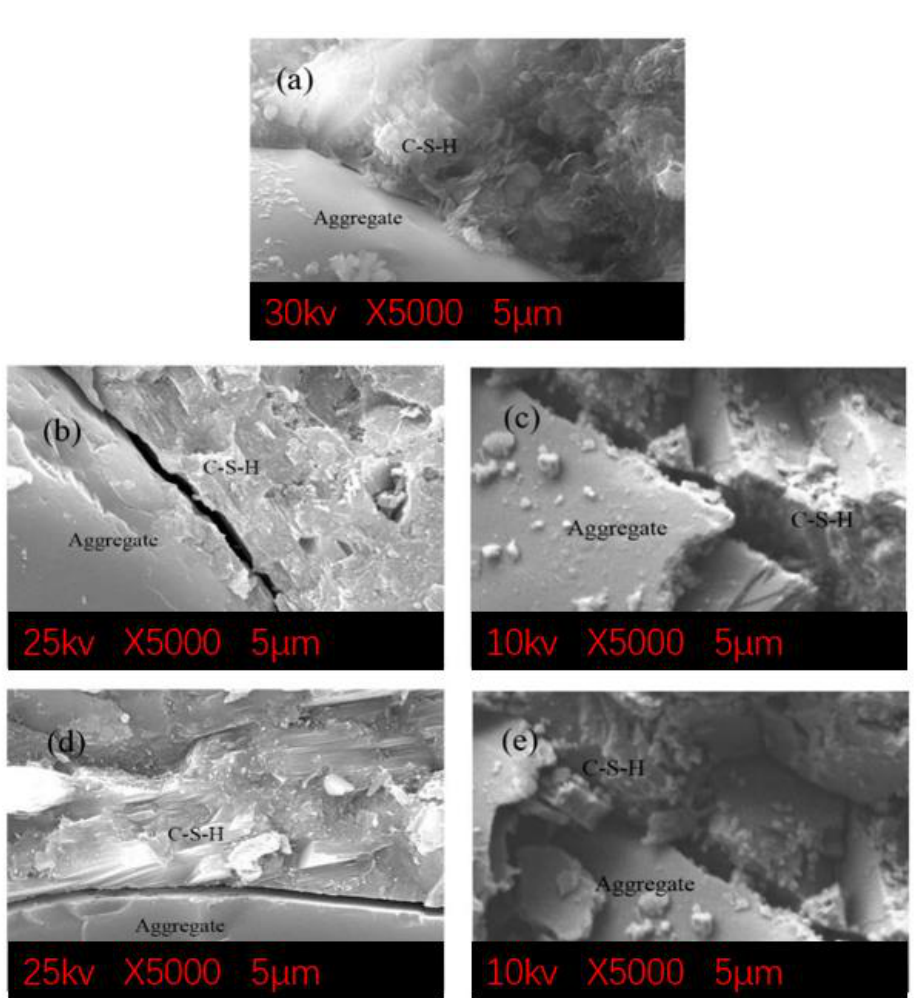
Figure 6. Microstructure of the interface transition zone in concrete under different environmental conditions and stress levels: ( a ) stress = 0% (seawater chamber); ( b ) stress = 15% (seawater chamber); ( c ) stress = 15% (freezing and thawing chamber); ( d ) stress level = 30% (seawater chamber); ( e ) stress level = 30% (freezing and thawing chamber).